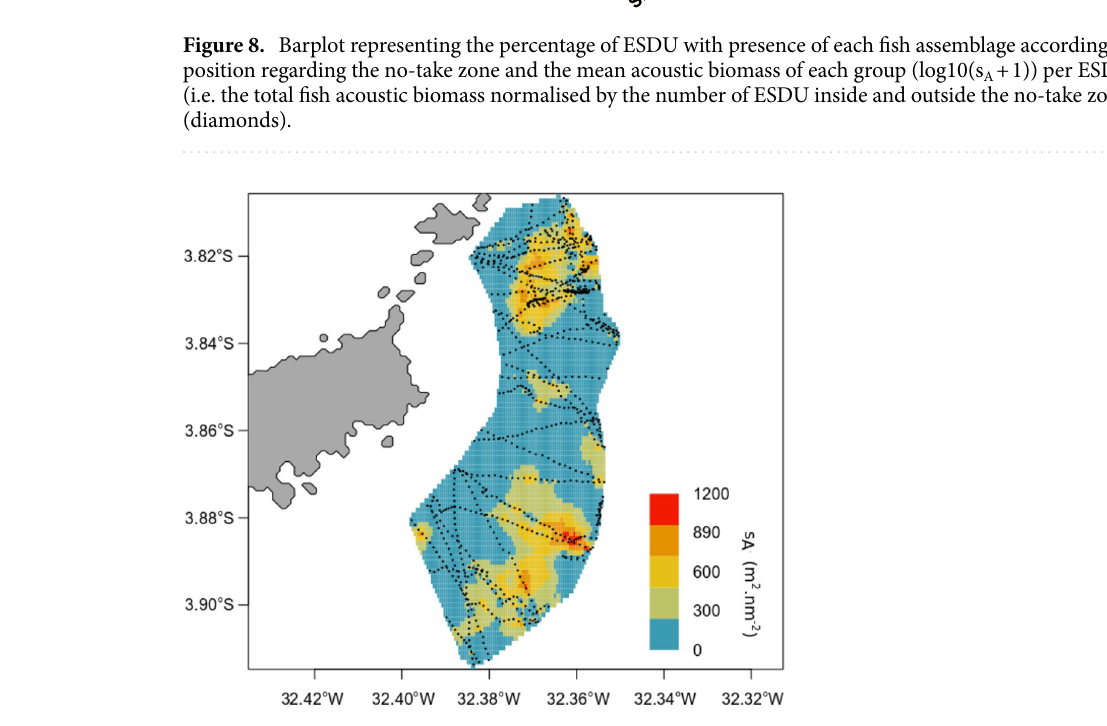
Figure 9. Interpolated distribution of the black triggerfish distributed in 5 classes of values of s A . The black dashed lines represent the acoustic transects. Map was created by the authors using R (https:// www.R- proje ct. org/) and RGeostats package 112 . Created with Adobe Illustrator software (https:// www. adobe. com) by graphic designer Pierre